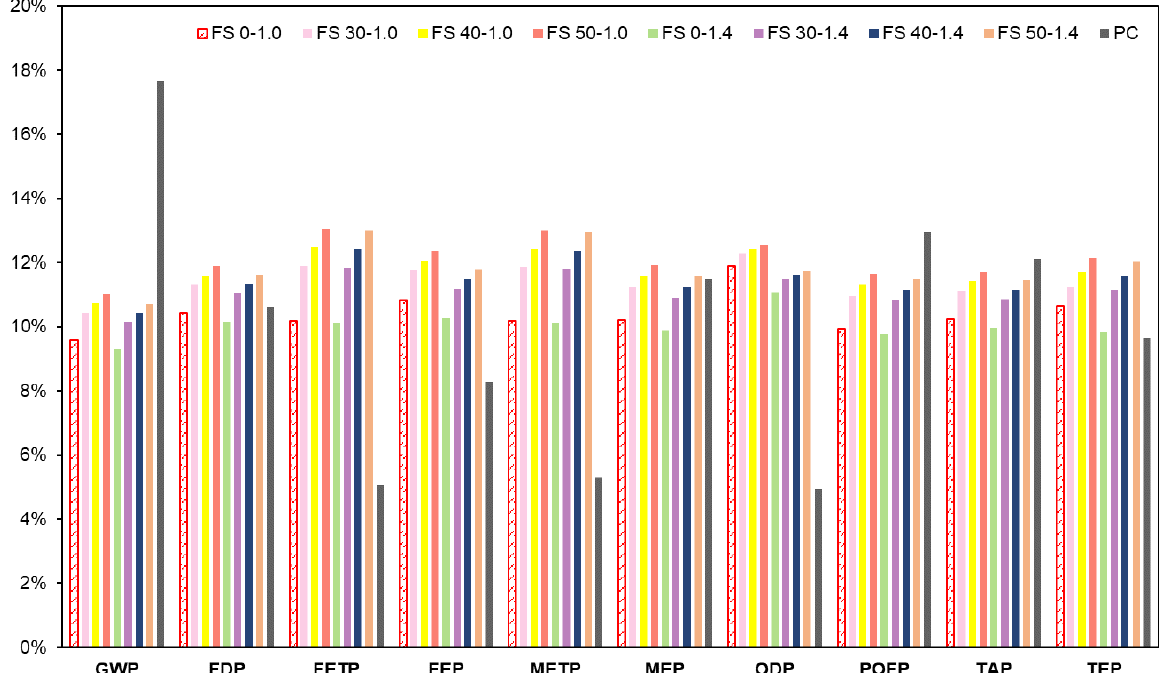
Figure 28. Normalized impact of AAC and PC concrete on midpoint damage categories.